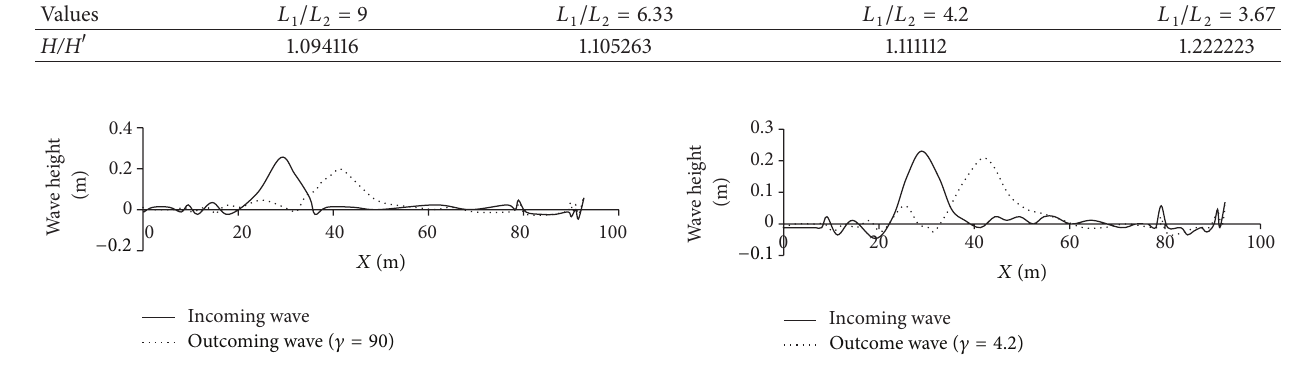
Figure 13: Free surface profile with ratio 9 in length.